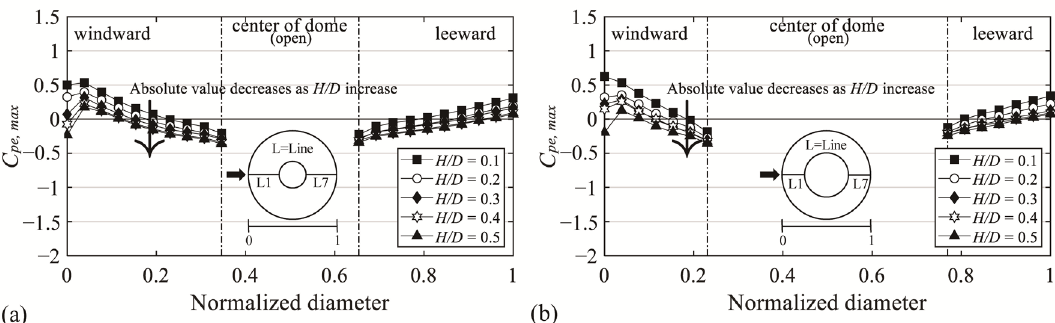
Figure 12. Variation of C pe, max depending on H/D of the central open dome: ( a ) open ratio = 30% and ( b ) open ratio = 50%.